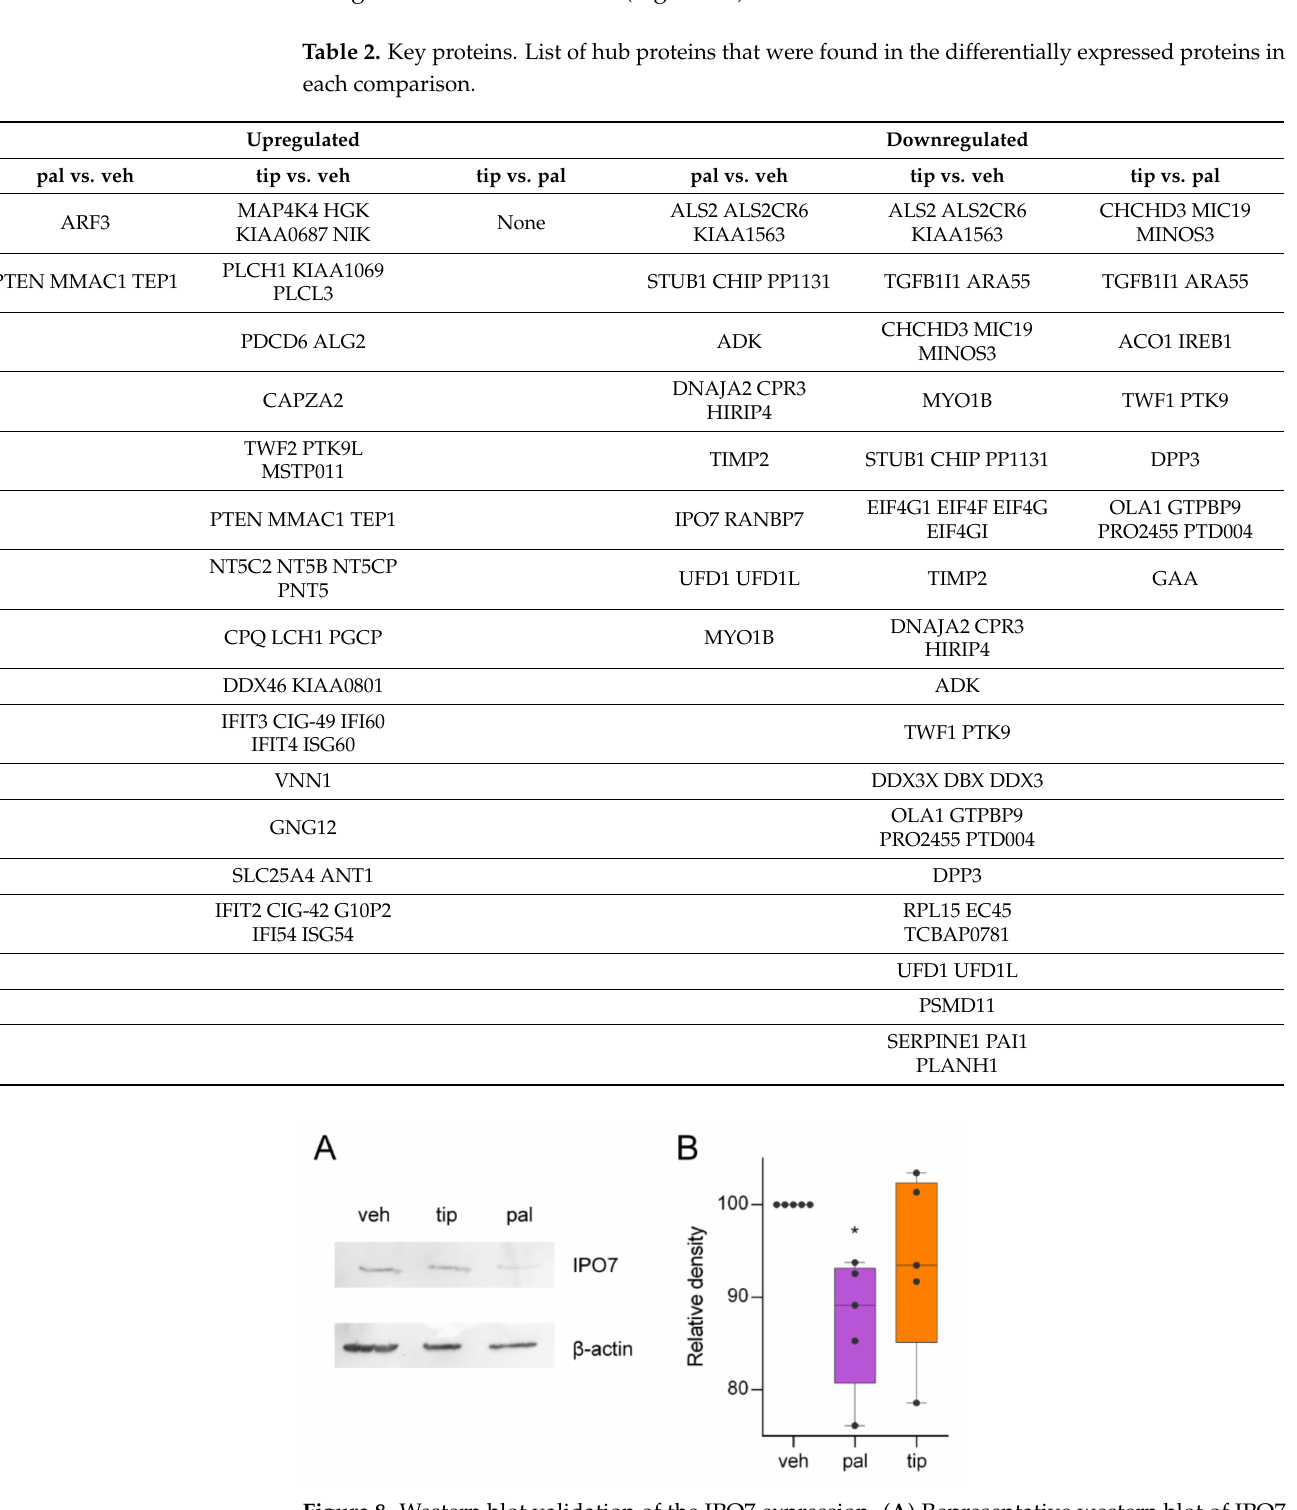
Figure 8. Western blot validation of the IPO7 expression. ( A ) Representative western blot of IPO7 expression under the three different treatments (load control: β -actin). ( B ) Statistic analysis of the band intensity from the western blot of IPO7 normalized by the control band signal (veh). One-way ANOVA and a Tukey’s test of veh vs. pal were used for comparisons; *: p =